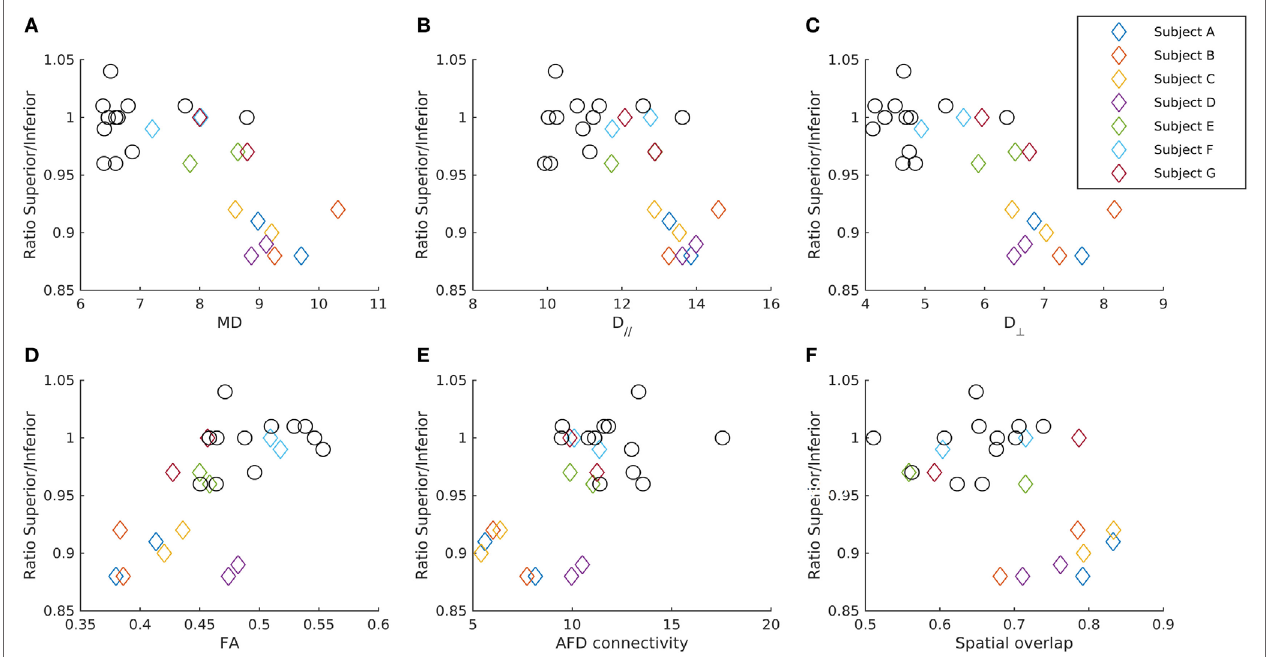
FigUre 3 | Relationship between the GCL_IPL thickness and diffusion parameters in the OR-V1d tracts. The ratio of the average GCL_IPL thickness in superior and inferior sectors in each eye for patients (diamonds) and controls (circles) plotted against (a) mean diffusivity MD, (B) axial diffusivity (D // ), (c) radial diffusivity (D ⊥ ), (D) fractional anisotropy (FA), and (e) apparent fiber density (AFD) connectivity in the ipsilateral OR-V1d tract, as well as against the (F) spatial overlap between the ipsilateral OR-V1d and OR-V1v tracts. Data are color-coded for each patient (Subjects A–G). Diffusivity in unit 10 − 4 mm 2 /s. AFD connectivity in arbitrary unit. Spatial overlap given as the Cohen’s kappa coefficient (47).